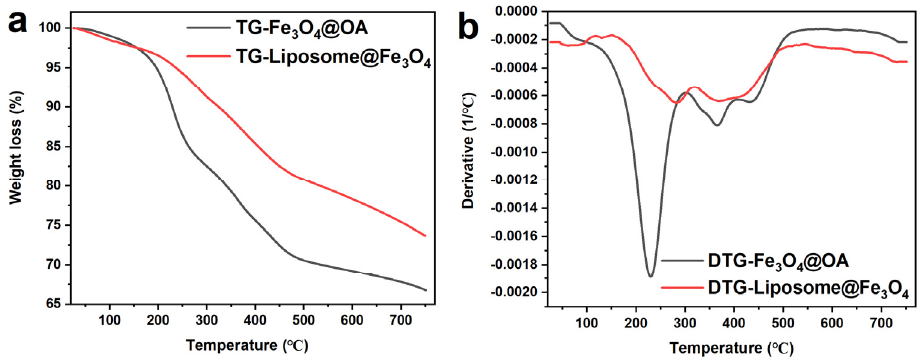
Figure 6. Magnetization curves of Fe 3 O 4 @OA nanoparticles and liposomes@Fe 3 O 4.